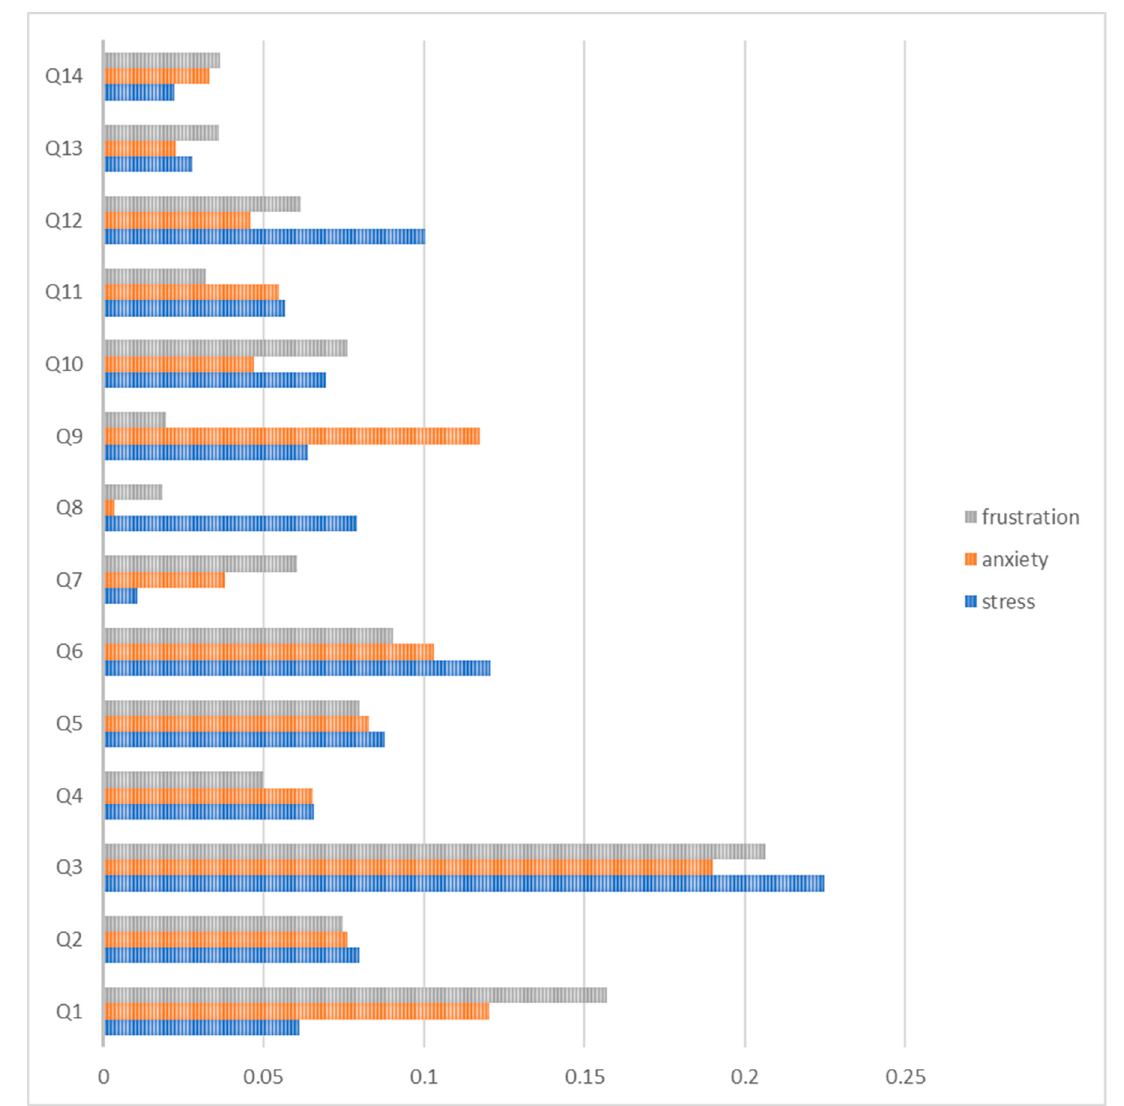
Figure 1. Relative importance summary of the RF model for overall stress, anxiety, and frustration throughout the registration step.